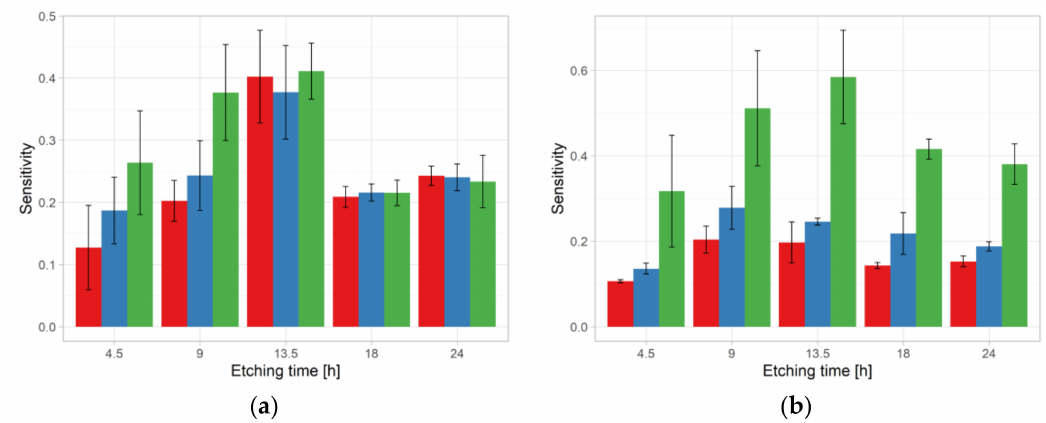
Figure 6. Sensitivity results obtained in Experiment 2 for 241 Am irradiation ( a ) and radon exposure ( b ). For color codes see Figures 3 and